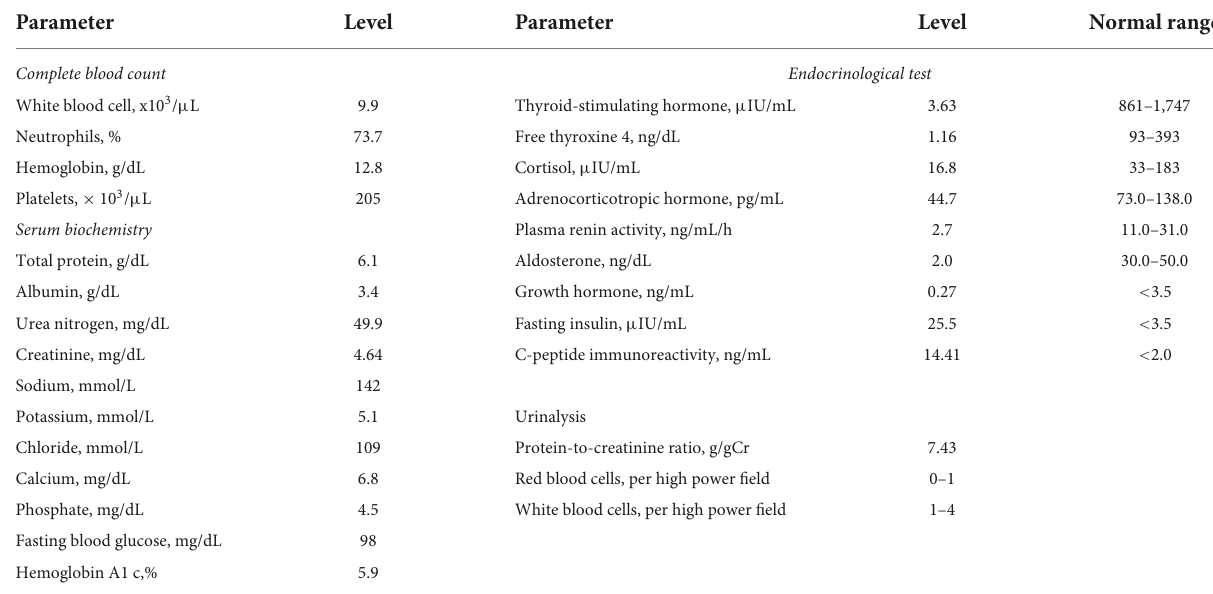
TABLE 1 Laboratory data at the first